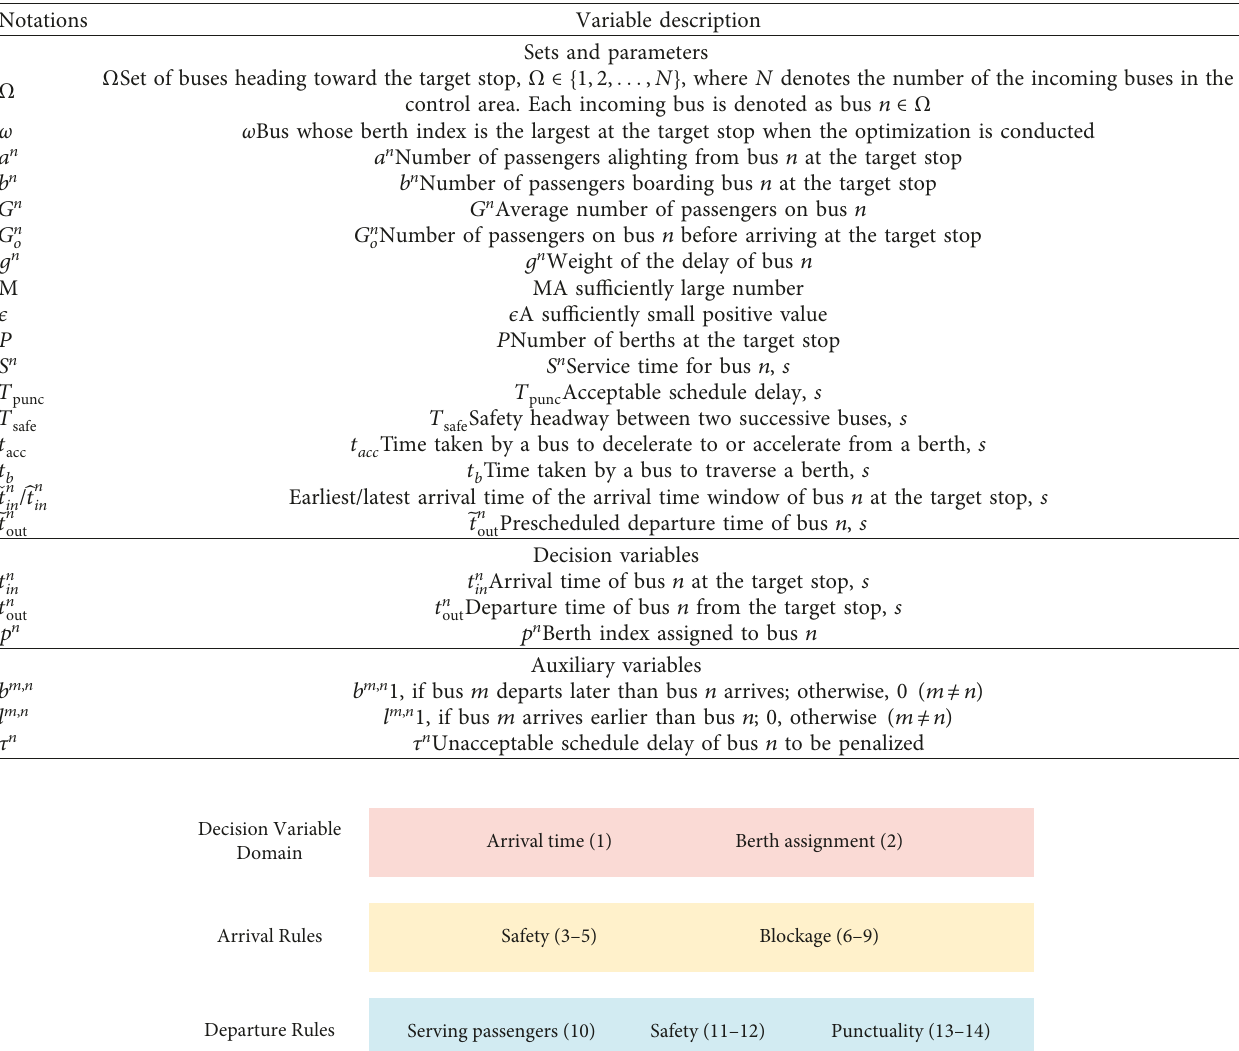
Table 1: Notations.